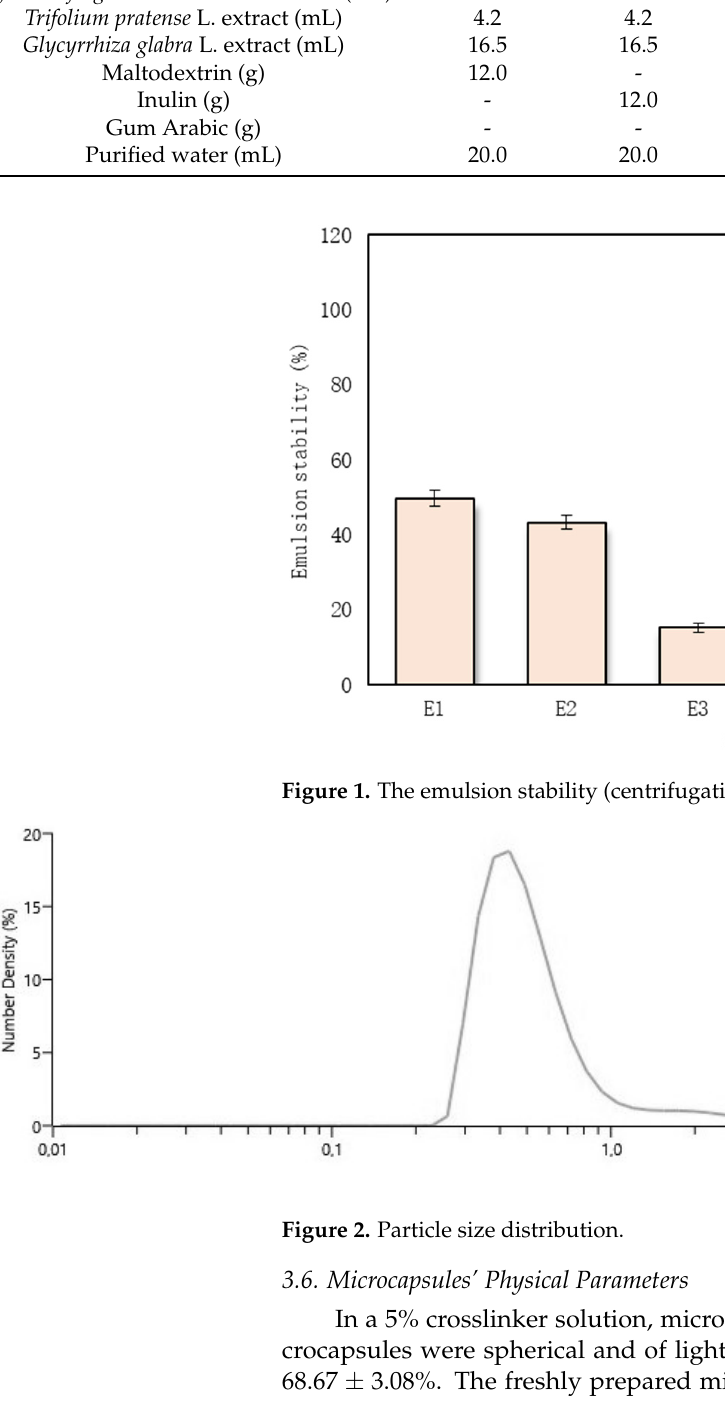
Figure 3. Extruded microcapsules ( A ) immediately after extrusion and ( B ) after drying the micro- capsules. Extrusion technology to produce microcapsules with essential oils and extracts is rarely used, but similar research results have been found. In a study with Myristica fragrans Houtt. essential oil, when polysorbate 80 is used as an emulsifier, microcapsules of size 2.120–2.280 mm with a strength of 4333.46–5116.70 g were formed in a 2% crosslinker so- lution [33]. Microcapsules with 1% of rosemary essential oil and without other excipients had a diameter between 0.950 mm and 0.756 mm (non-dry and dry, respectively; only sodium alginate 4% solution was used) [25]. Microcapsules’ swelling index in gastric media was from 19.74% to 13.96%, and algi- nate microcapsules did not swell in gastric fluid. At first, the microcapsules swelled a lit- tle, but after 30 min, the swelling index decreased. Conversely, microcapsules swelled from 25.22% to 121.59% in the intestinal medium (Figure 4). After a day, the microcapsules